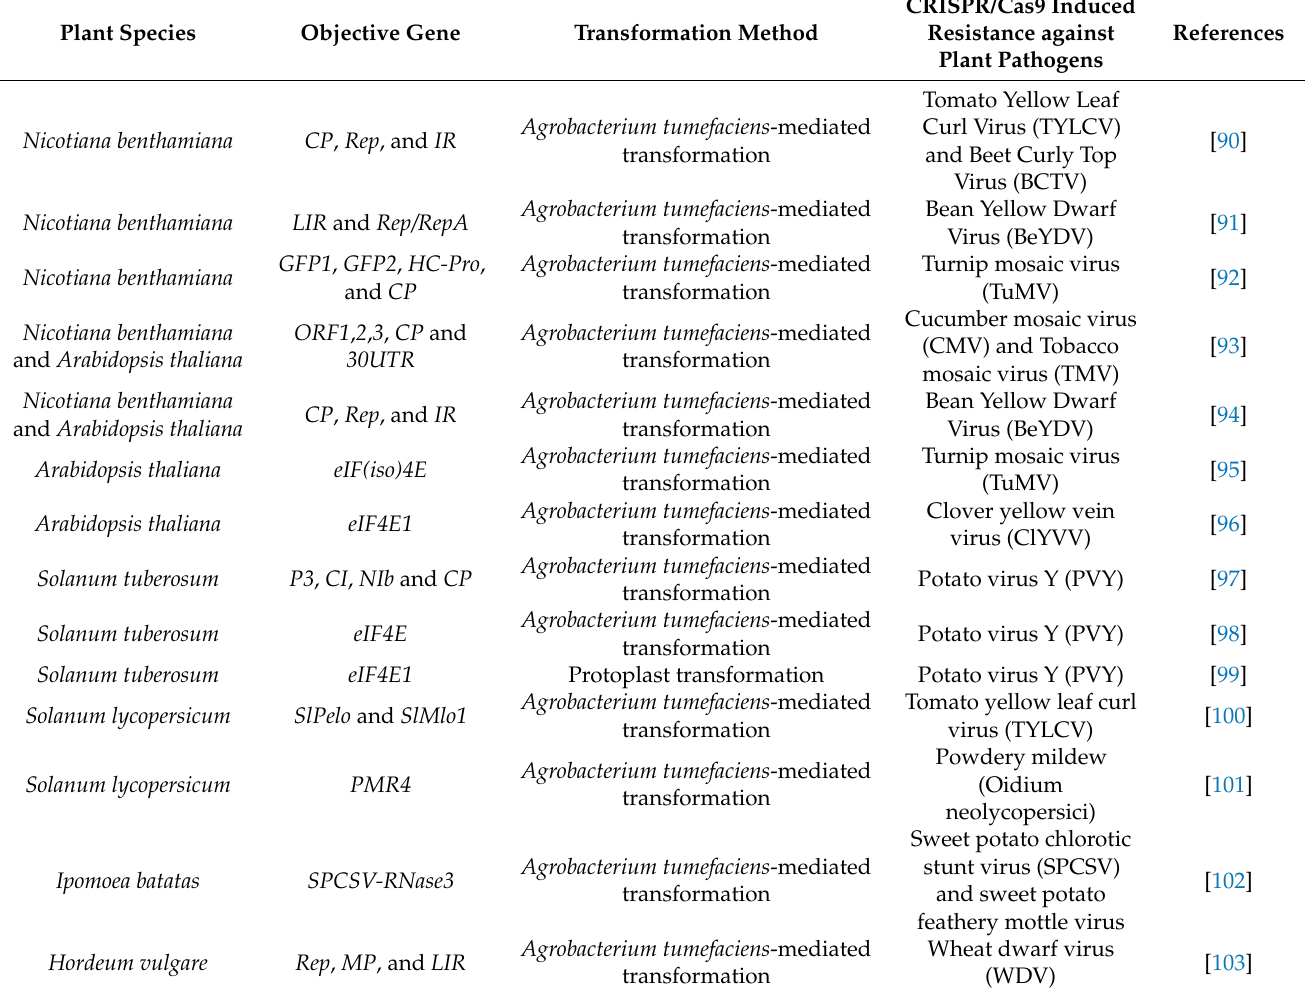
Table 2. CRISPR/Cas induced plant resistance against various